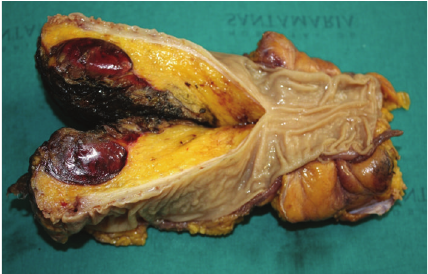
Figure 4: 84-year-old male with presacral myelolipoma. Gross examination revealed a well-circumscribed, fleshy, and red-brown tumor, measuring 5,5 cm of greatest dimension. It was located in perirectal tissue, adjacent to the circumferential margin, and was 1cm distant of the muscularis